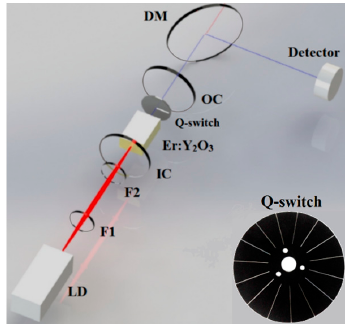
Figure 1. Schematic setup of the Q-switched Er:Y 2 O 3 ceramic laser. LD: laser diode; IC: input coupler; OC: output coupler; DM: dichroic mirror.